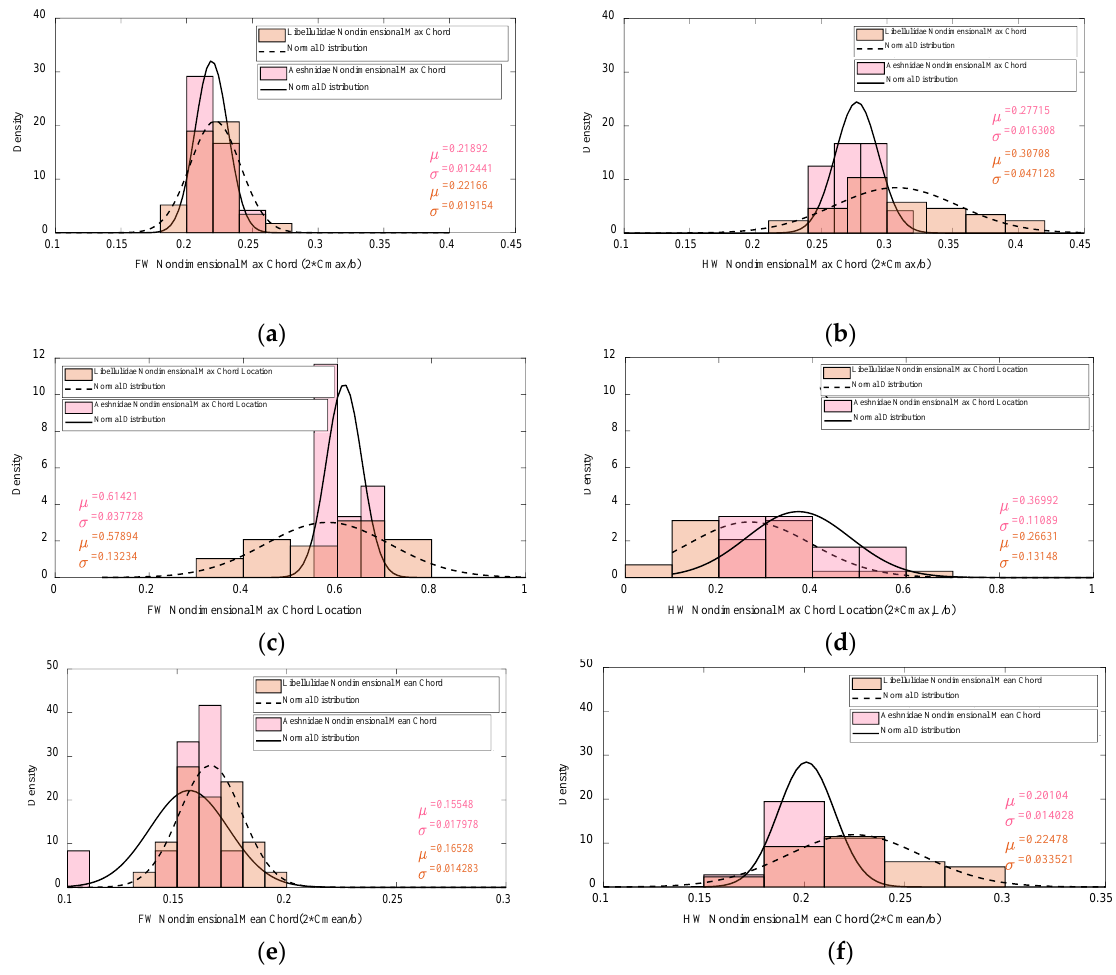
Figure 8. Probability density function and fitted normal distribution of non-dimensional parameters: FW max chord ( a ), HW max chord ( b ), FW max chord location ( c ), HW max chord location ( d ), HW mean chord ( e ) and HW mean chord ( f ) of the two families of Aeshnidae and Libellulidae.